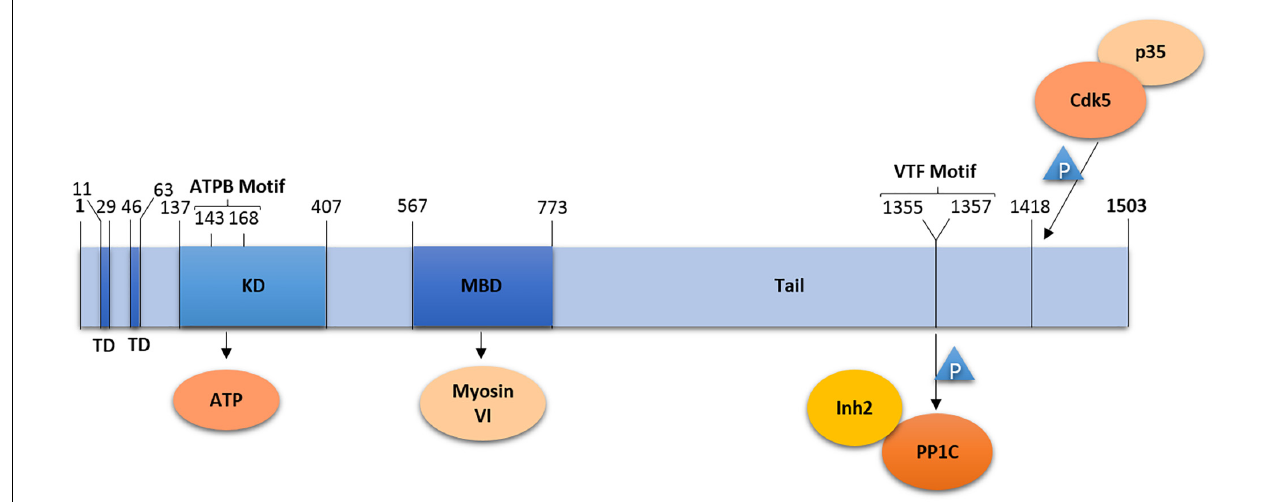
FIGURE 1 | Domain organization of LMTK2. LMTK2 contains two transmembrane domains (TD), followed by a kinase domain (KD) with an ATP binding (ATPB) motif, a Myosin VI binding domain (MBD), and a tail domain. The kinase domain residue K 168 is critical for LMTK2 catalytic activity. LMTK2 interacts with PP1c via its VTF motif (residues 1355–1357). LMTK2 is phosphorylated in its residue S 1418 , by the complex Cdk5/p35. Numbers indicate amino acid